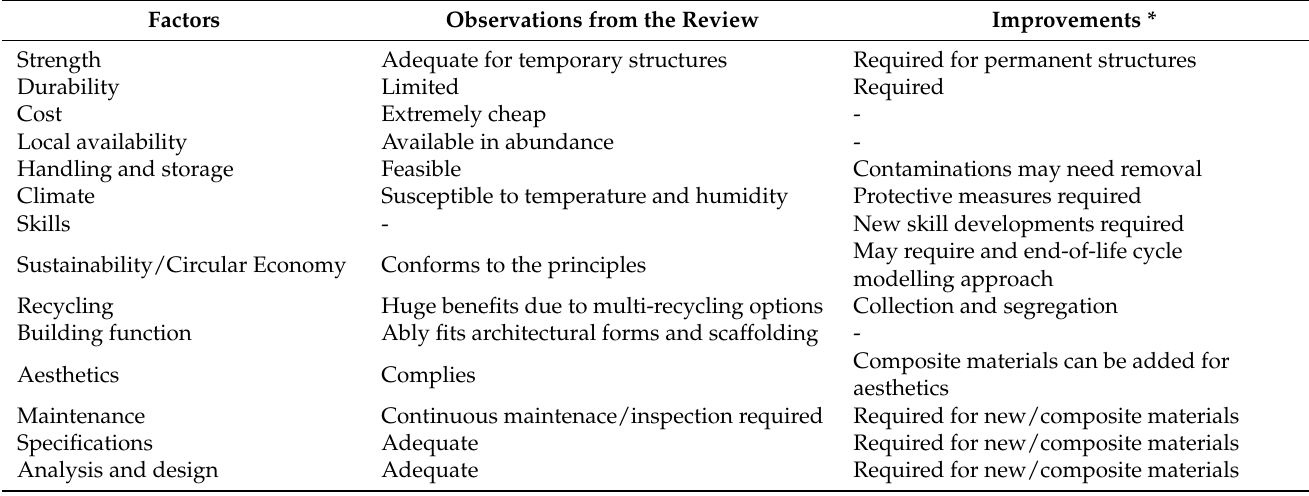
Table 6. Summary analysis of cardboard as a construction